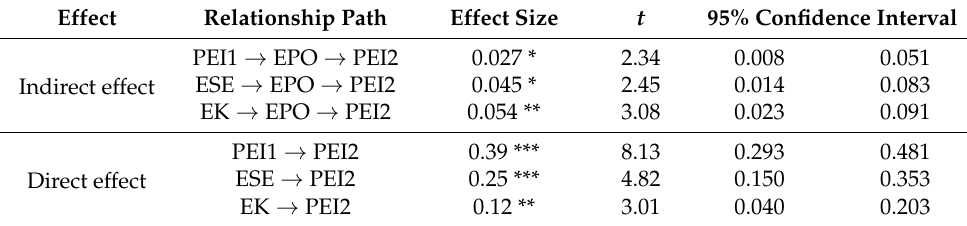
Table 4. Mediation